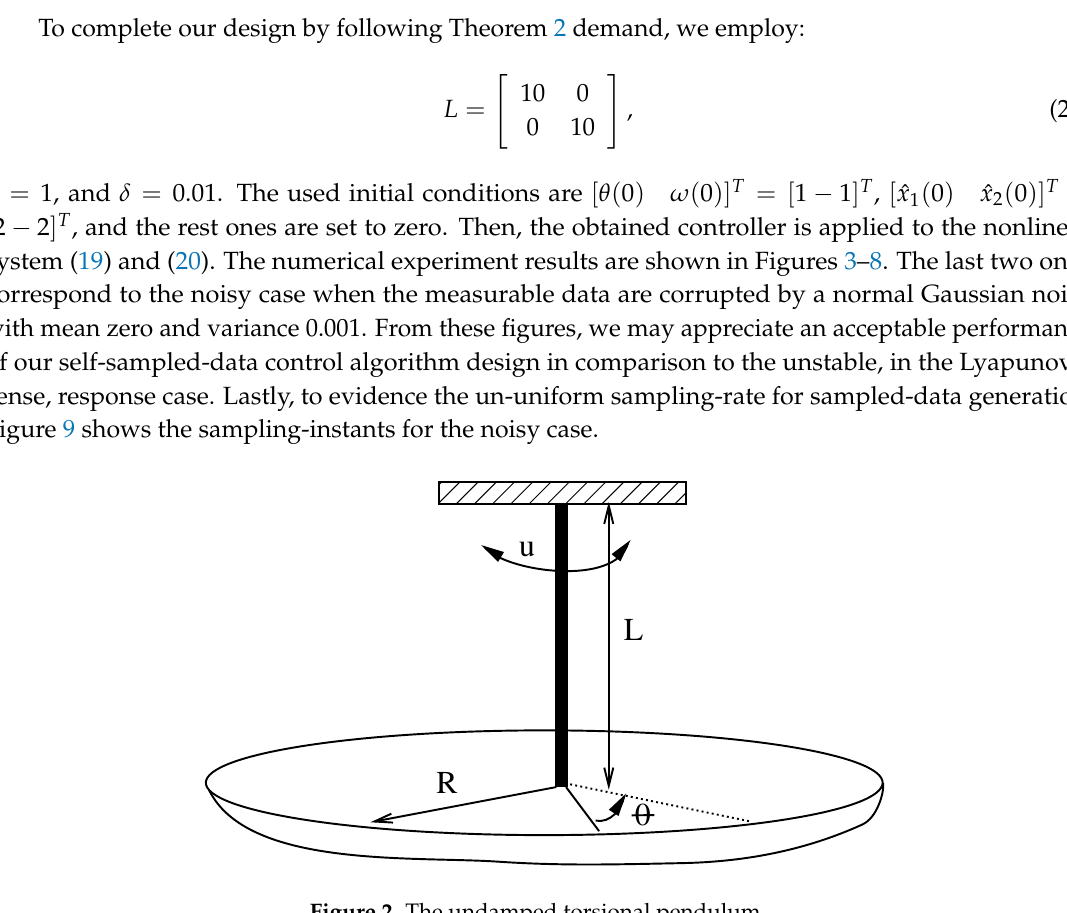
Figure 2. The undamped torsional pendulum.